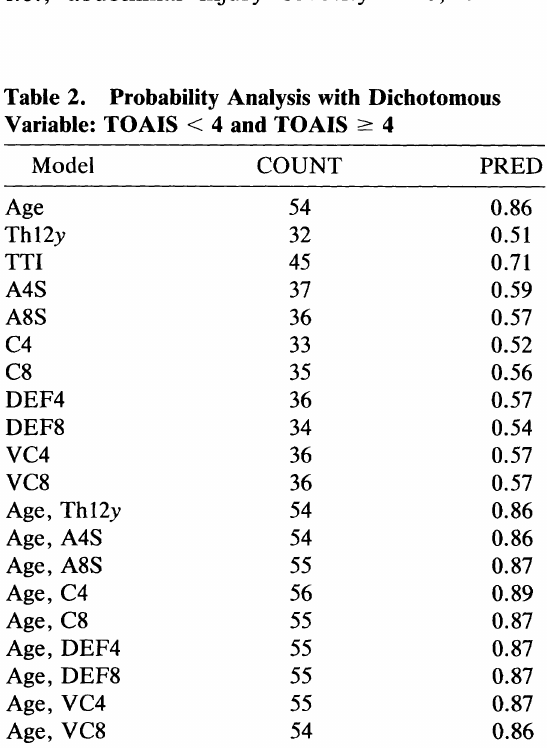
Table 2. Probability Analysis with